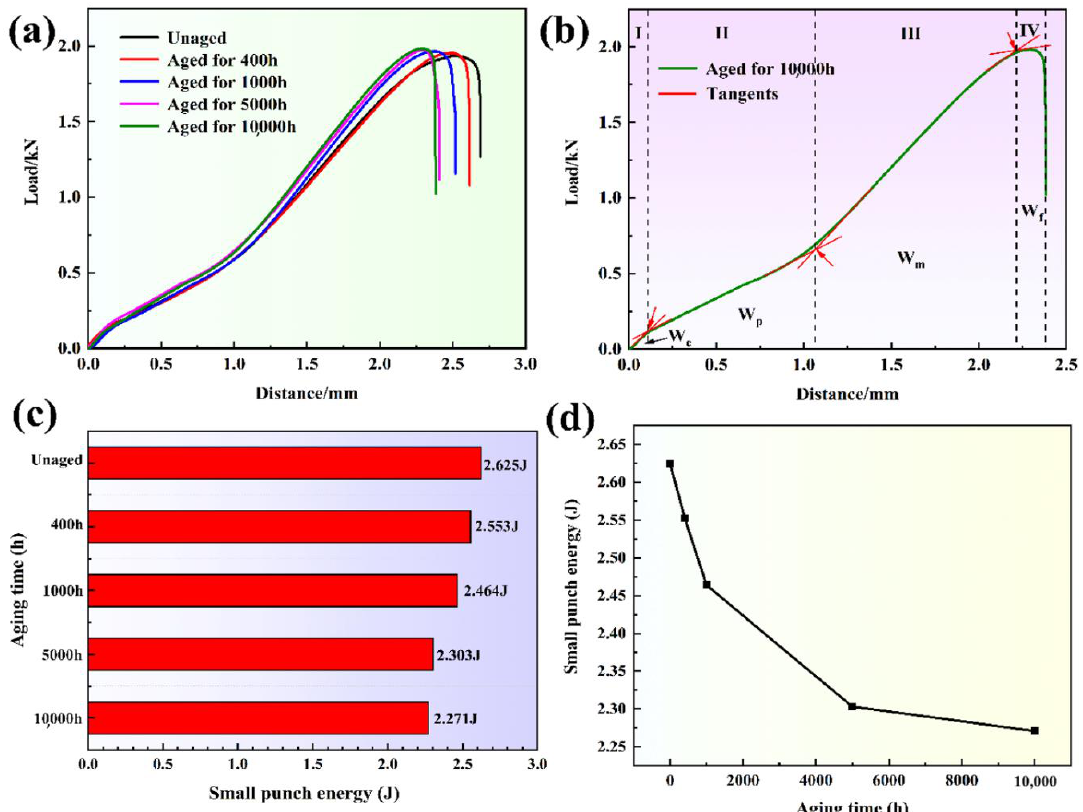
Figure 6. ( a ) The load-displacement curves of the specimens under di ff erent thermal aging times, ( b ) the classification diagram of the load-displacement curve area of the unaged small punch specimen, ( c , d ) the change chart of small punch energy with thermal aging